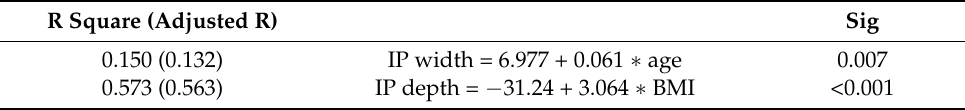
Table 2. Linear regression analyses of IP width and IP depth with age and BMI,